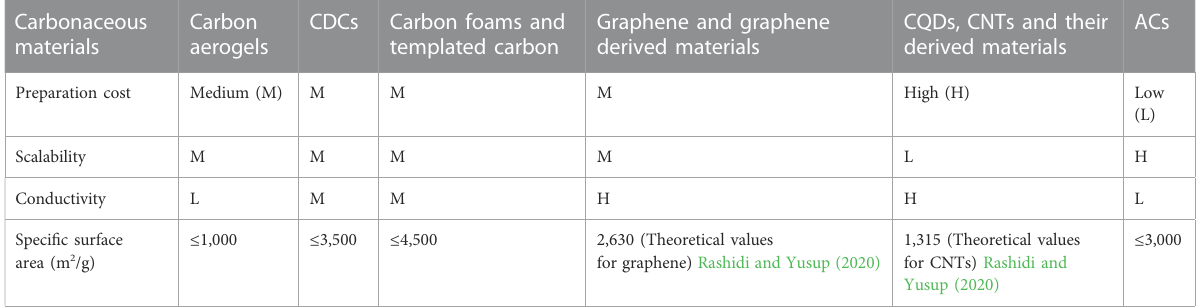
TABLE 1 Comparisons of different carbonaceous electrode materials for